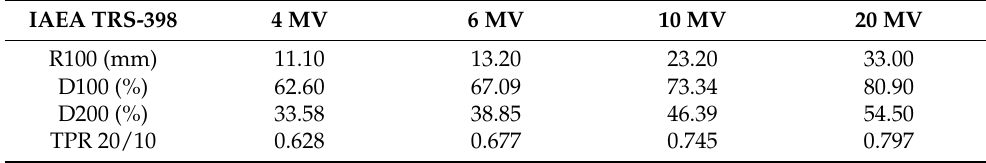
Table 1. Characteristics of percentage depth dose curves for 4, 6, 10, and 20 MV photon beams.